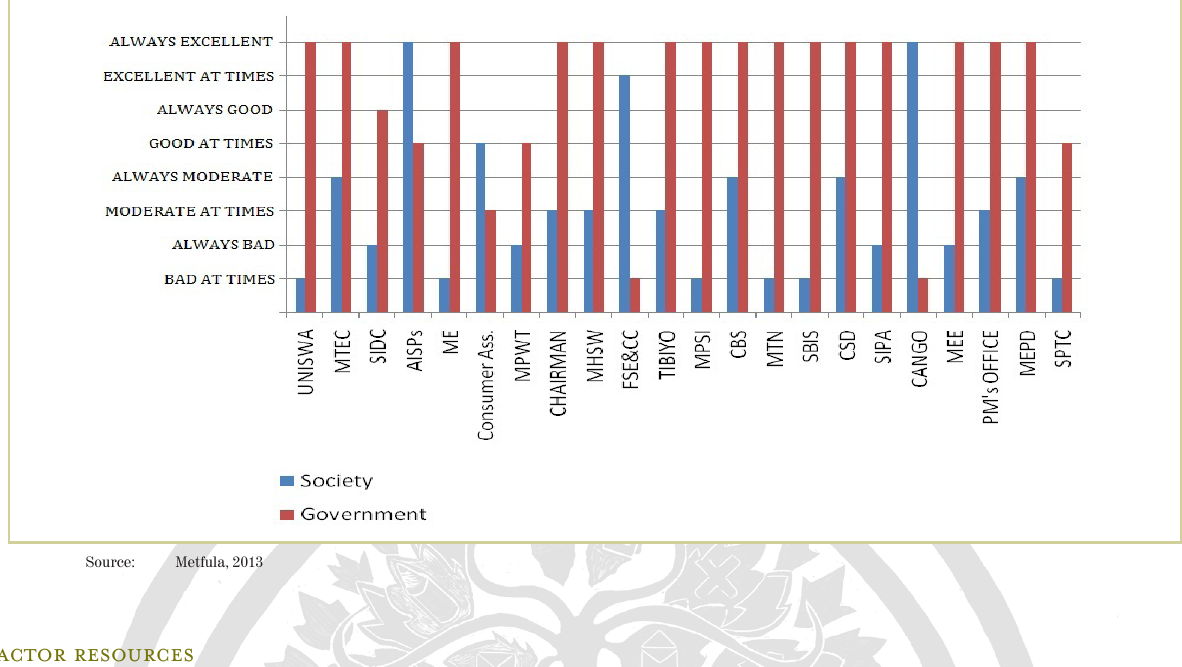
FIGURE 2: REPUTATION (INFLUENCE/AUTHORITY) OF POLICY ACTORS TO GOVERNMENT AND